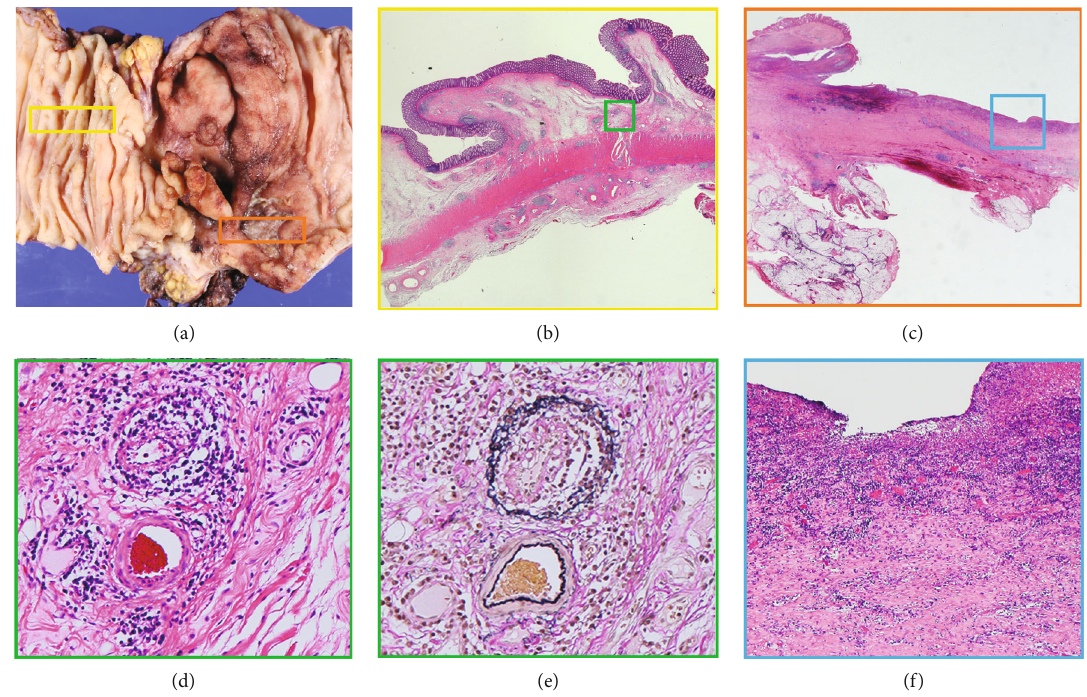
Figure 2: Pathological fi ndings. (a) Gross appearance of resected specimens. Severe stenosis and ulceration are present at the ileocecal region. (b) Low-magni fi cation image of the area surrounded by the yellow frame. Phlebitis is found in the submucosa beneath the normal mucosa away from the main lesion (hematoxylin/eosin (HE) stain). (c) Low-magni fi cation image of the area surrounded by the orange frame (HE stain). (d) Magni fi ed image of the area surrounded by the green frame. Lymphocytic phlebitis is present but the arteries are not in fi ltrated (HE stain). (e) Elastica van Gieson stain. (f) Magni fi ed image of the area surrounded by the blue frame. In the middle part of the lesion, there was no phlebitis. There were only ulcers and fi brosis (HE stain).